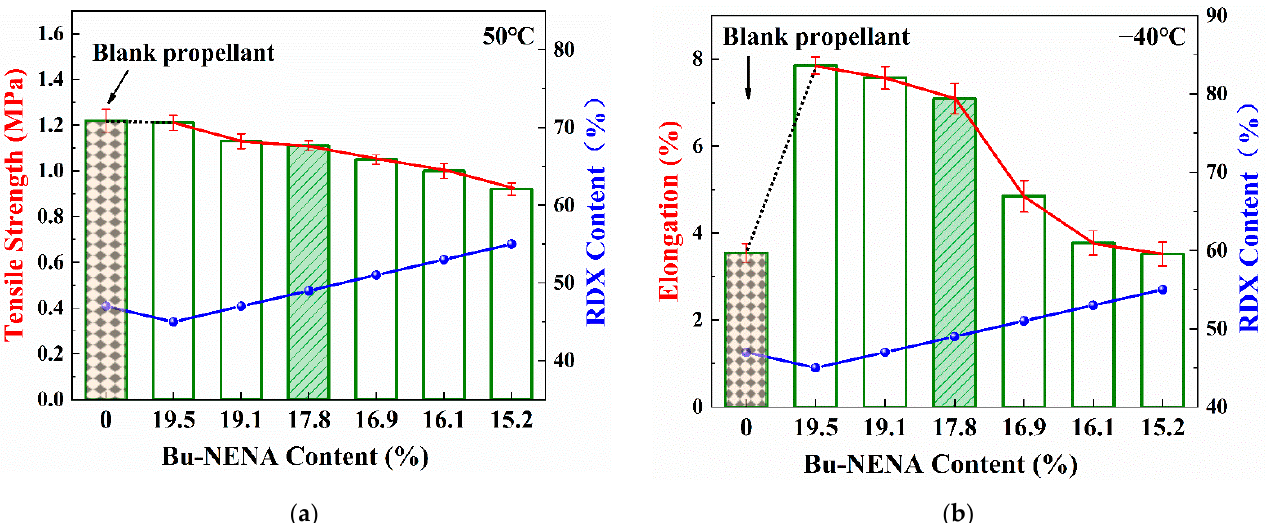
Figure 1. Mechanical properties of EMDB propellant: ( a ) Tensile strength of EMDB propellant at 50 °C; ( b ) Elongation of EMDB propellant at − 40 °C.